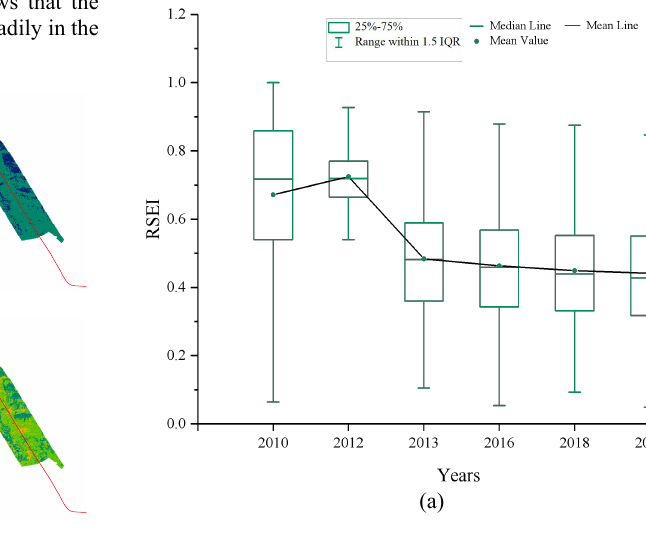
Fig.2. Spatial distribution of RSEI in 2010, 2012, 2013, 2016, 2018, 2020. The legend of Fig.2 is Grade 1: 0-0.2; Grade 2: 0.2-0.4; Grade 3: 0.4-0.6; Grade 4: 0.6-0.8; Grade 5: 0.8-1. Based on six RSEI spatial distribution maps, the box diagram of the study area and the histogram of the area’s percentage of different grades of RSEI by year are drawn in Fig. 3. Specifically, the box diagram (Fig. 3a) reflects the distribution of RSEI value in RSEI maps from 2010 to 2020, and the histogram of grade area percentage (Fig. 3b) delineates the proportional changes of each ecological grade. It can be observed that the total proportion exceeded 90% of grades 3, 4, and 5 along the Warsaw section during 2010-2012 (Fig. 3b). The total area proportion of grades 1, 2 increased significantly to about 40% compared with the before of CER-Express operation, while the total area proportion of grades 3, 4, and 5 decreased year by year during 2013-2020. This indicates that the total proportion of poor and fair RSEI values increases, while the total proportion of moderate, good, and excellent gradually decreases from 2010 to 2020. According to Fig. 3 (a), the mean value of RSEI in 2010 and 2012 fluctuates between 0.6-0.8, and the mean value of RSEI in 2013, 2016, 2018, and 2020 fluctuates between 0.43-0.45. Moreover, the RSEI values at 25% and 75% locations in 2010 are higher than those at the same locations in 2013. From the perspective of the median value line of RSEI, the overall trend is downward from 2010 to 2020 and the median values of 2013, 2016, 2018, and 2020 are significantly lower than those of 2010 and 2012. Therefore, this indicates that the overall level of eco-environment quality shows a downward trend during 2010-2020 in the study area. In addition, the ecological environment of the area along the railway degrades compared with that before the CER-Express